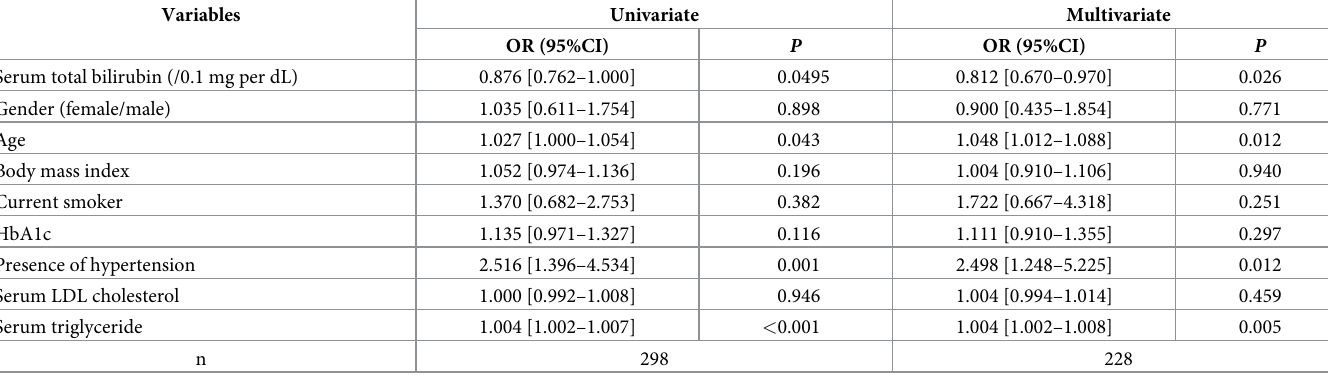
Table 2. Multivariate logistic regression model predicting progressive renal decline (PRD).